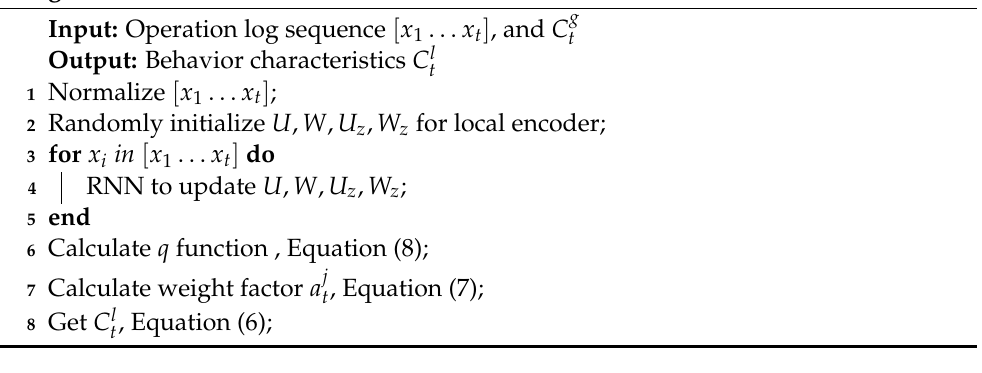
Algorithm 2: Local encoder.